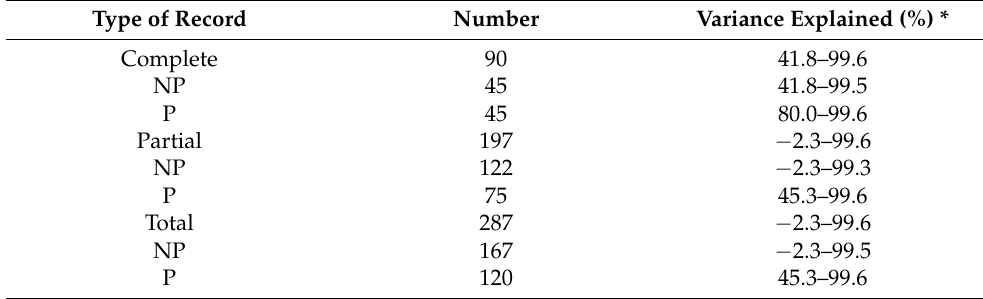
Table 1. Numbers of complete and partial streamflow records for each type (N = nonperennial and P = perennial) of reach used in this study, and the range in the amount of variation (pseudo- r 2 values) in mean daily streamflow explained by the RF models for each type of reach and